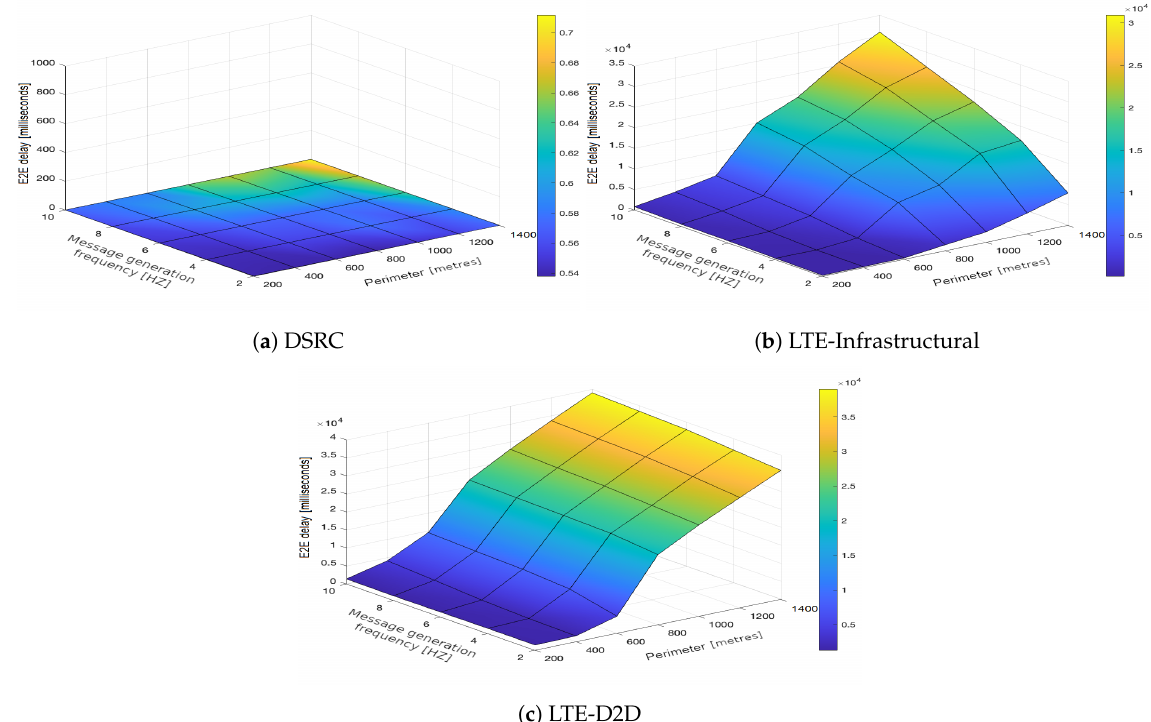
Figure 10. End-to-end delay obtained for the traffic intensity of 750 vehicles per